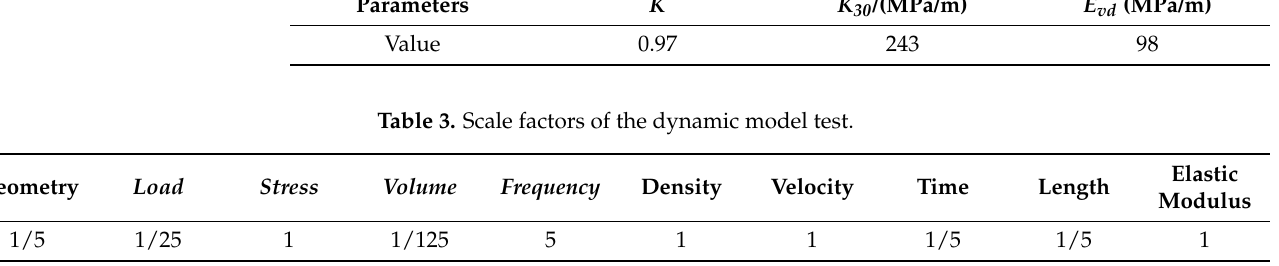
Table 2. Tested results of the embankment.